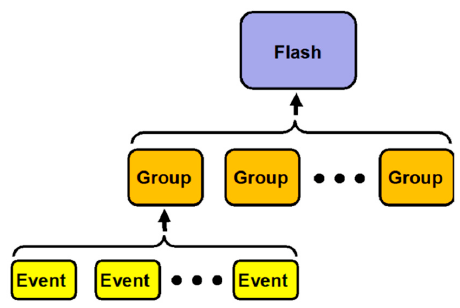
Figure 4. Hierarchical relationship between a flash, groups and events [28].